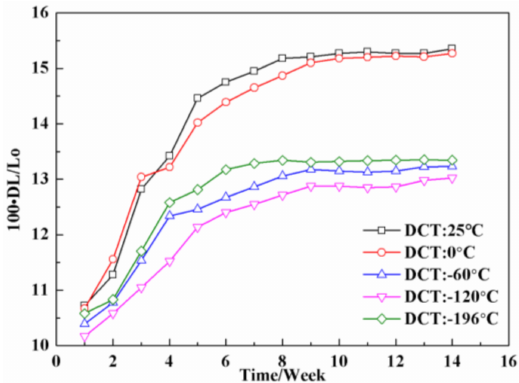
Figure 9. Curve of 7075 aluminum alloy ring sample size changes vs. aging